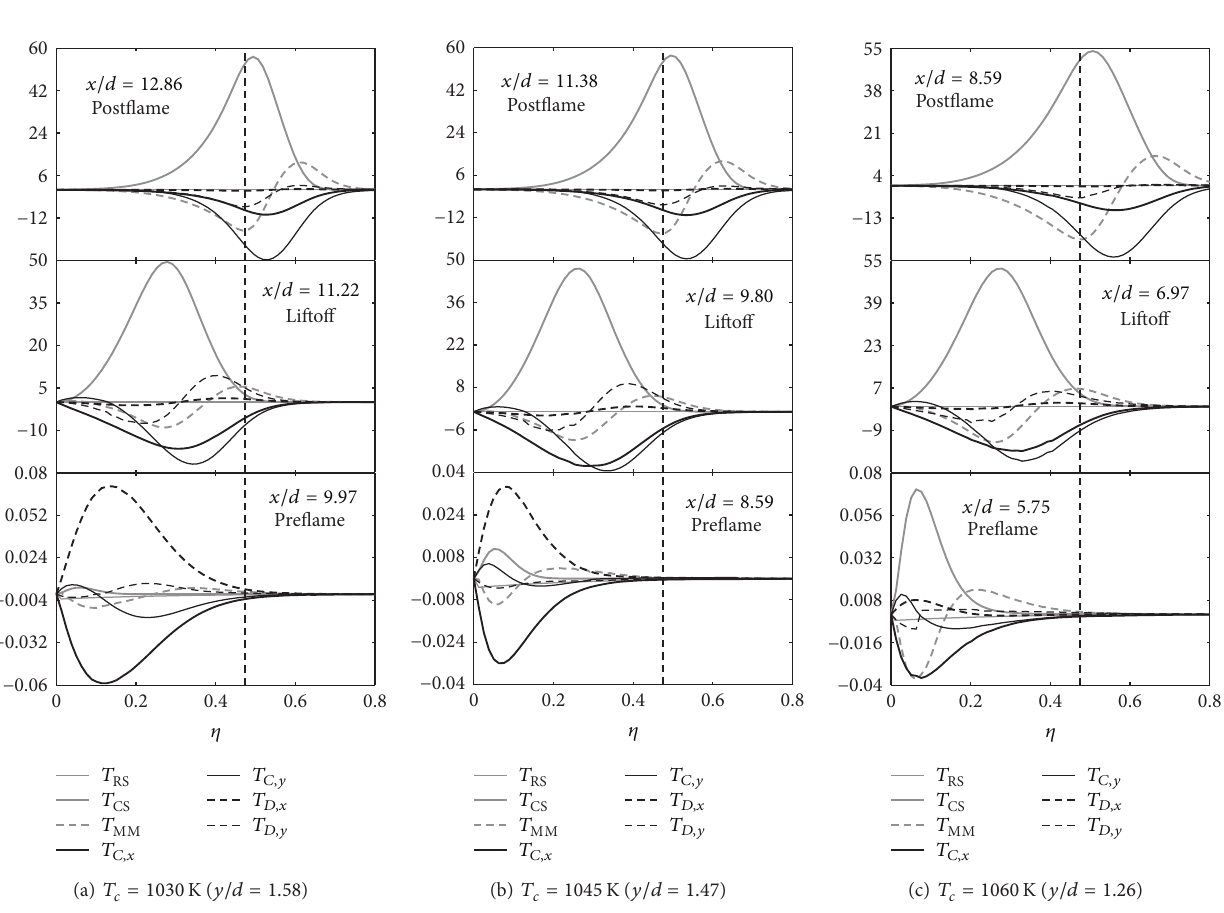
: radiative source; 𝑇 : RS CS